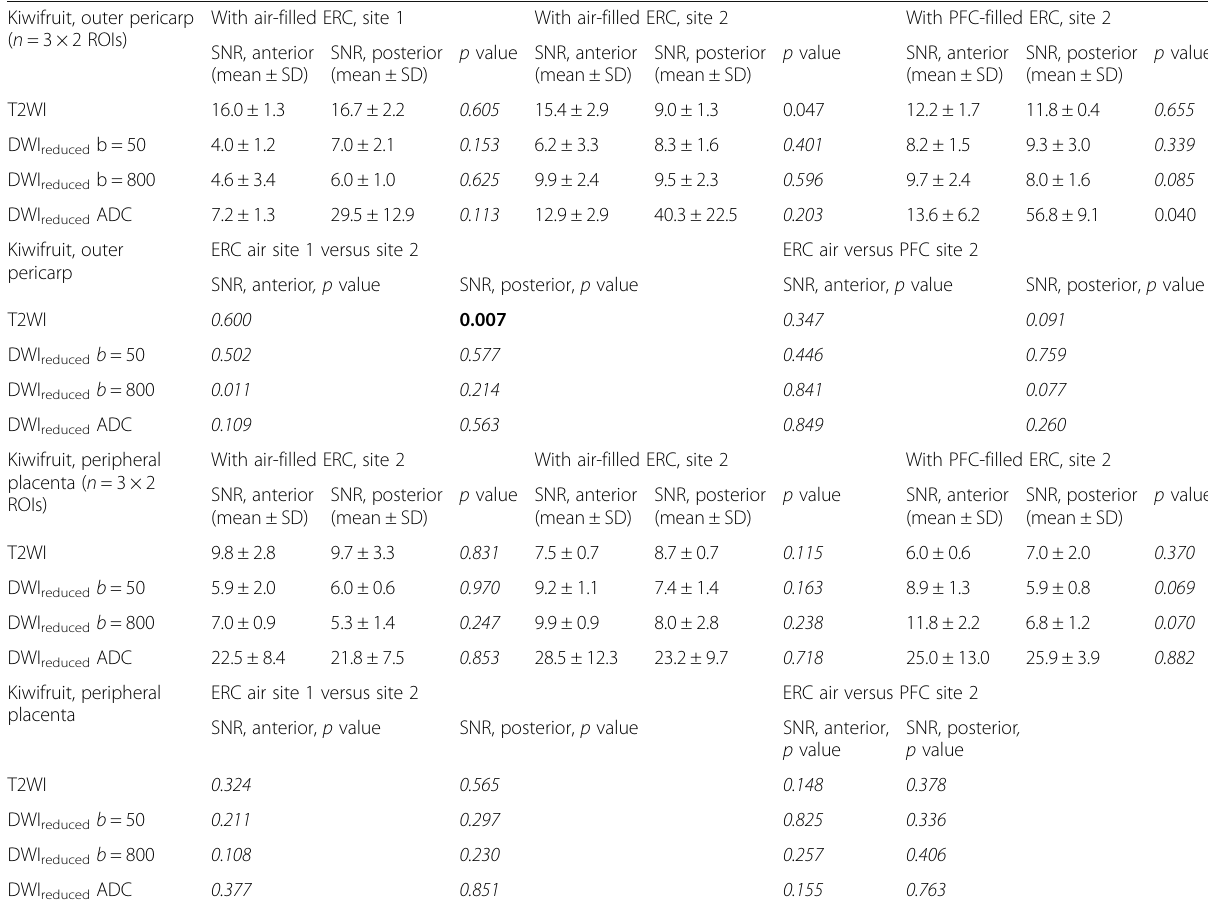
Table 4 Signal-to-noise ratios in one kiwifruit examined with an endorectal coil filled with air at both site 1 and site 2, and with perfluorocarbon in site 2